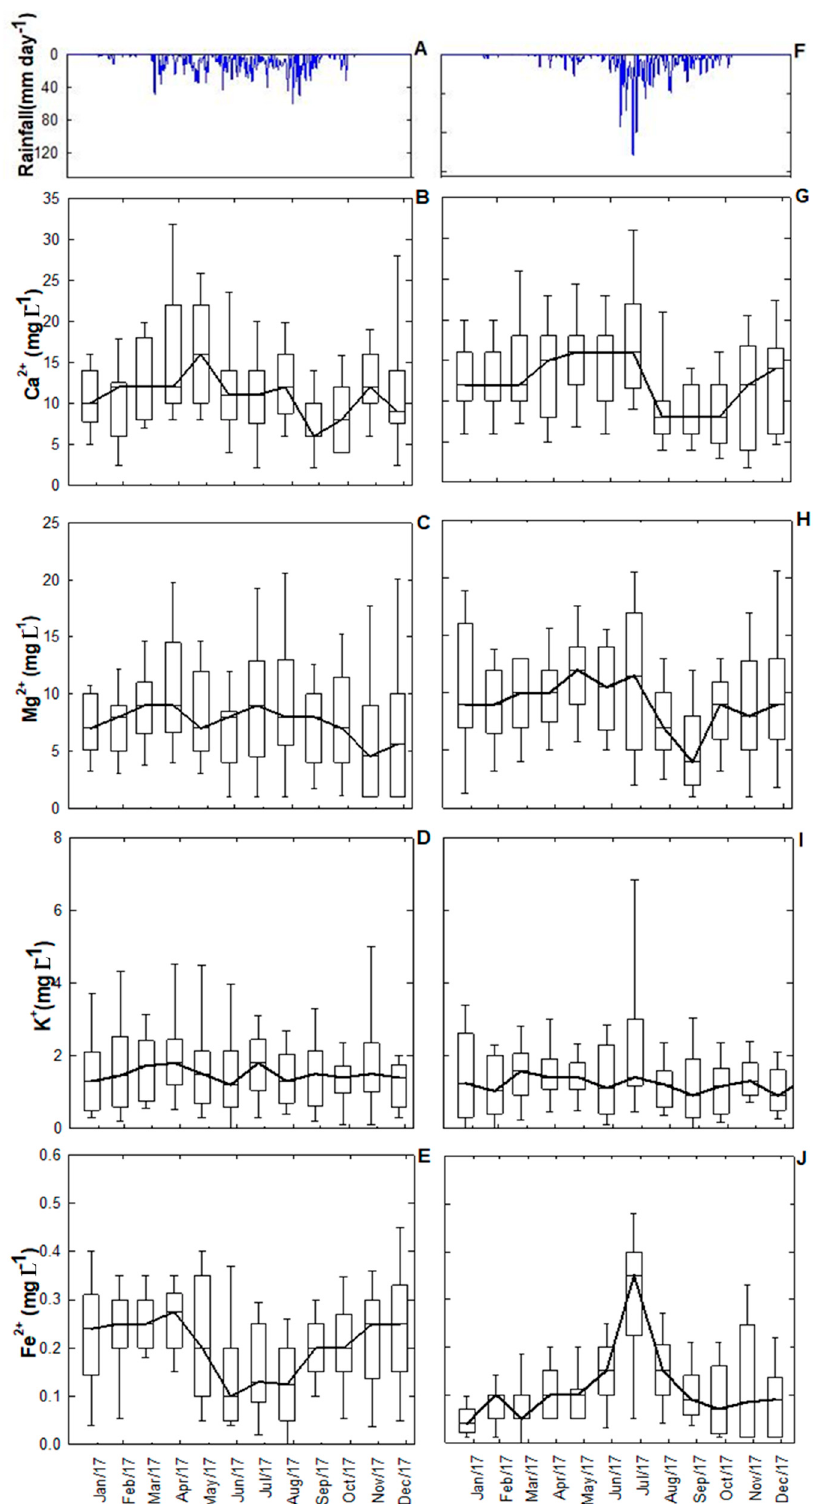
Figure 6. The concentration of major cations (Ca 2+ , Mg 2+ , and K + ) and iron (Fe 2+ ) in groundwater in 2017. ( A – E ) is for Dangishta, and ( F – J ) is for Robit Bata watershed. The box plots are based on data from 32 wells in Dangishta and 35 wells in Robit Bata.